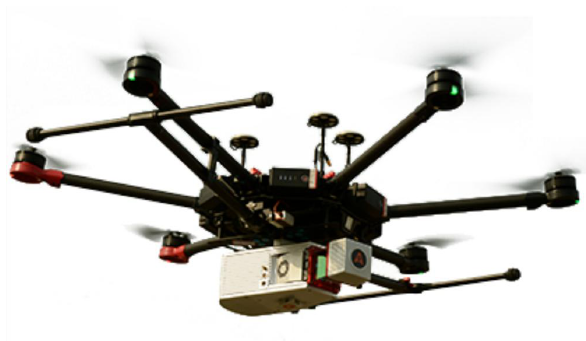
Figure 4 Dajiang M600 Pro UAV with LiDAR AS-300H.